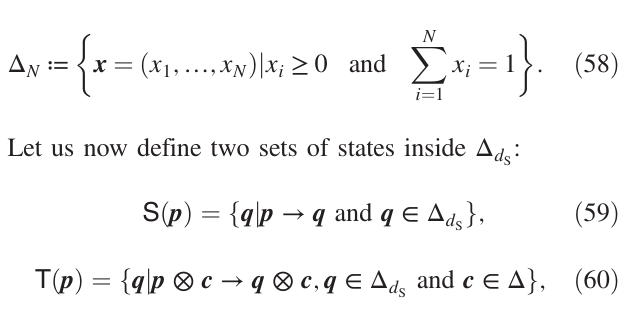
p ⋆ ; q ⋆ ; ϵ FIG. 3. Probability p that a random state of succ ð C Þ dimension d drawn from probability distribution P can C dist catalyze a fixed-state transformation p ⋆ → q ⋆ . Each panel cor- responds to a different distribution: (a) Rayleigh P , (b) uniform ray P , and (c) exponential P . The insets illustrate an exemplary unif exp distribution of eigenvalues c ð i Þ of a random catalyst c ð i Þ drawn k according to a respective distribution and then